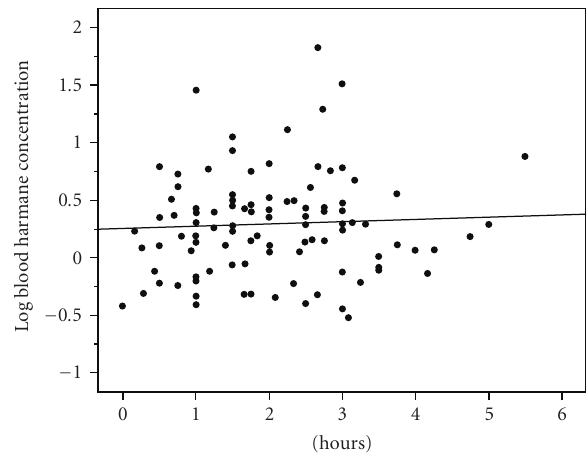
Figure 1: Hours between food consumption and phlebotomy ( x axis) and log blood harmane concentration (g − 10 /ml) ( y axis). Regression line is shown (Spearman’s r = 0 . 03, P = .